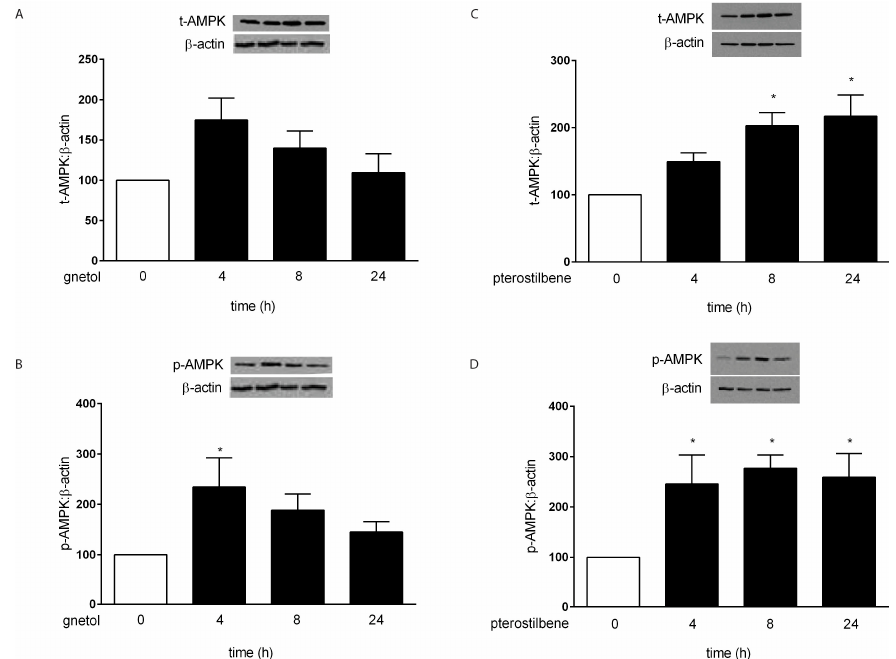
Figure 2. Gnetol and pterostilbene increase AMPK α levels and/or phosphorylation. Gnetol (5 µg/mL) ( A ) did not significantly affect total AMPK levels, and yet ( B ) promoted activation of AMPK α as reflected by phosphorylation at Thr172. Pterostilbene (1 µg/mL) increased both ( C ) total AMPK levels and ( D ) AMPK α phosphorylation. n = 3–4. * p < 0.05 vs. control (open bars).